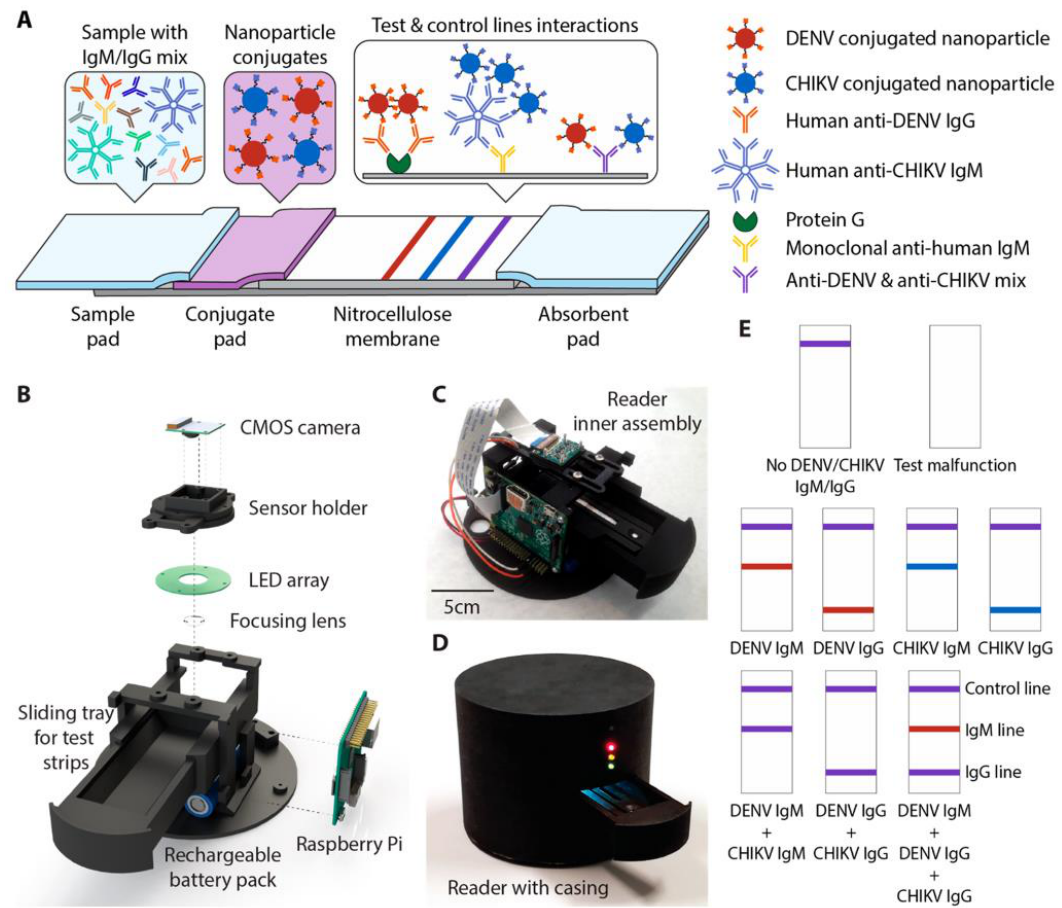
Figure 2. A 4-plex color encoded lateral flow test strip and an optical scanner make up this quick diagnostic platform. ( A ) Multiplex lateral flow test strip architecture. DENV and CHIKV antibodies can attach to red and blue nanoparticle conjugates, respectively. The first test line (red) captures nanoparticle conjugates labeled IgG, while the second test line (blue) captures labeled IgM, resulting in color development. When both DENV and CHIKV Ab of the same isotype are present in a sample, the test line generates an intermediate hue that is a mix of red and blue. The control line catches both unbound nanoparticle conjugates and unbound nanoparticle conjugates (purple). ( B ) An optical reader with an exploded view is designed to reduce color detection variations. ( C ) The optical reader’s internal assembly. ( D ) is fully built and protected from the elements. To avoid ambient light, the open sliding tray is closed during imaging. The lights on the indicator show the progress of imaging. ( E ) Illustrations of test strip appearance for various diagnostic circumstances. DENV and CHIKV are both present in purple cases. Ab has the same isotype (adapted with permission from Wang et al. 2019 131, Copyright © 2019, American Chemical Society)